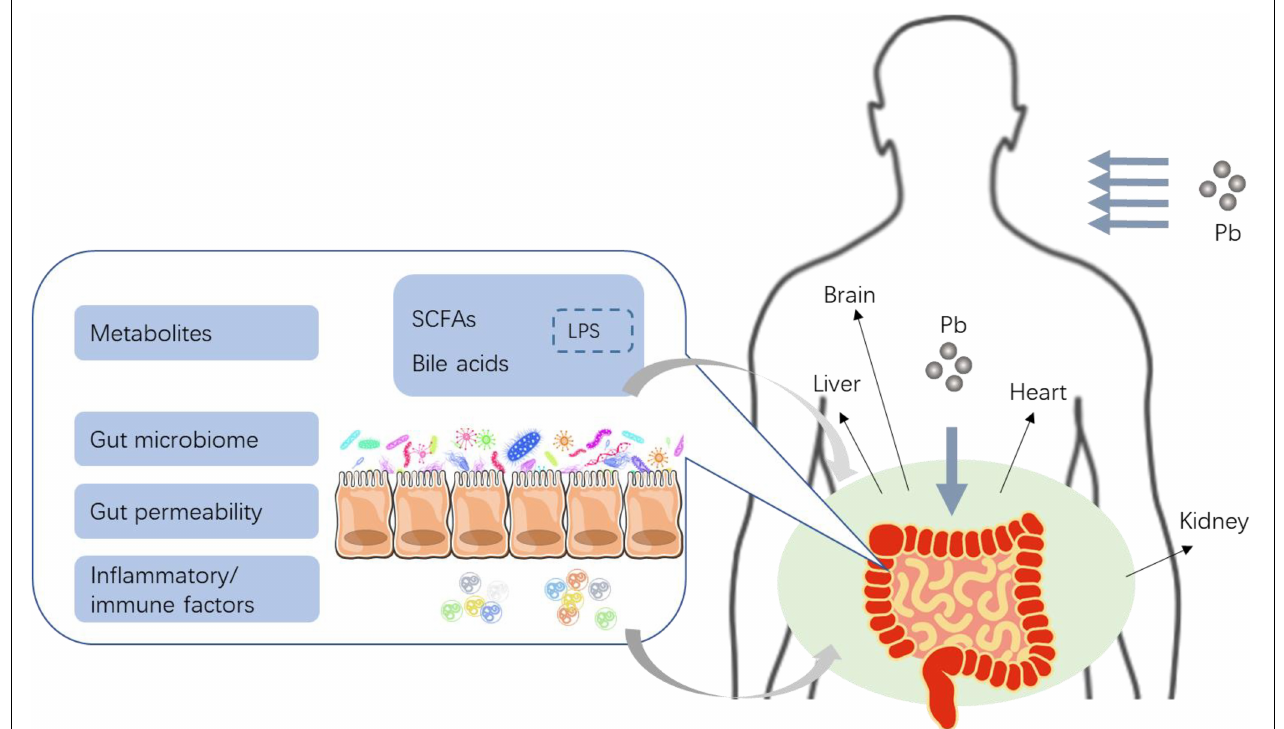
FIGURE 1 | The proposed effects of Pb toxicity on gut, and the critical role of gut barrier and microbiome in Pb toxicity (reproduced from Yuan et al., 2019). Pb entered the gut then changed the microbial homeostasis, including the balance of gut microbe and microbial metabolites such as SCFAs, BA, and/or LPS. Local inflammation and oxidative stress of gut could be induced by Pb generally. Pb could disrupt the gut barrier and increased gut permeability directly or indirectly. Then inflammatory cytokines, immunologic factors, as well as microbial metabolites such as bile acids (BA) and short-chain fatty acids (SCFAs), might enter the enterohepatic circulation via a weak gut barrier to finally induce systematic